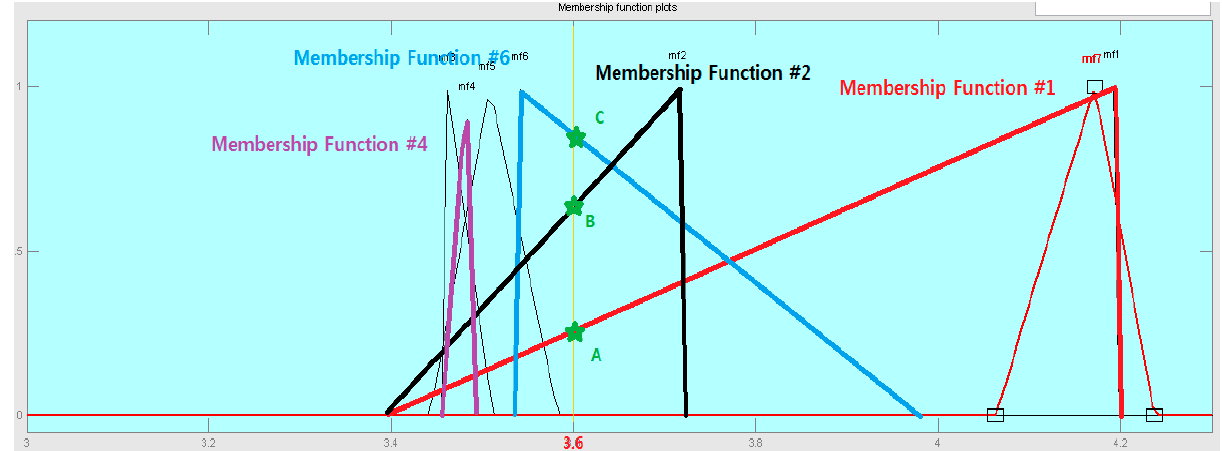
Figure 9. Membership Function example after applying unstructured data: the vertical axis is Membership Function, and the horizontal axis is the traffic volume. Membership function #1~7 means sequentially from distribution of Sunday traffic volume to Saturday traffic volume.